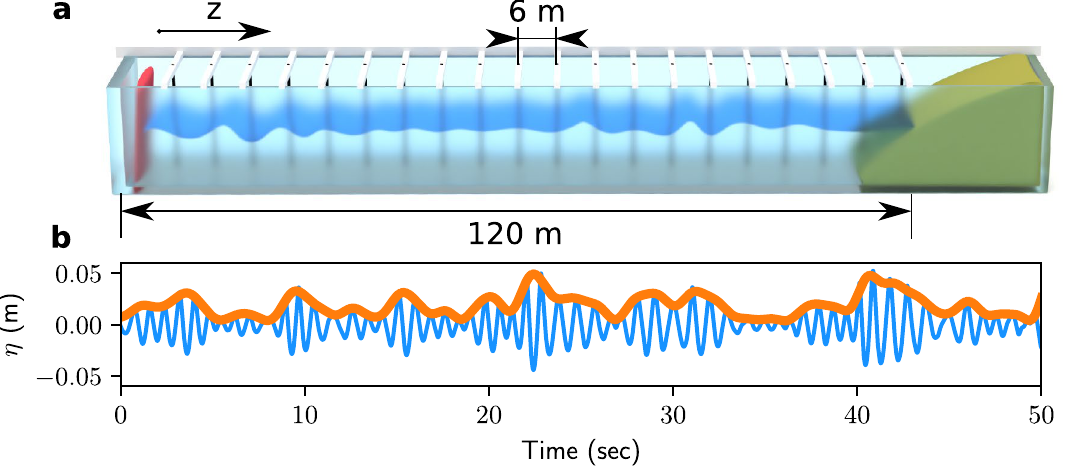
Figure 2. Experimental facility. (a) Schematic representation of the 120m-long water tank facility at École Centrale de Nantes. The surface elevation is recorded by a set of probes placed every 6 m of the water tank length. (b) Typical experimental wave train (surface elevation η , blue line) and its envelope (orange line) reconstructed by using the Hilbert